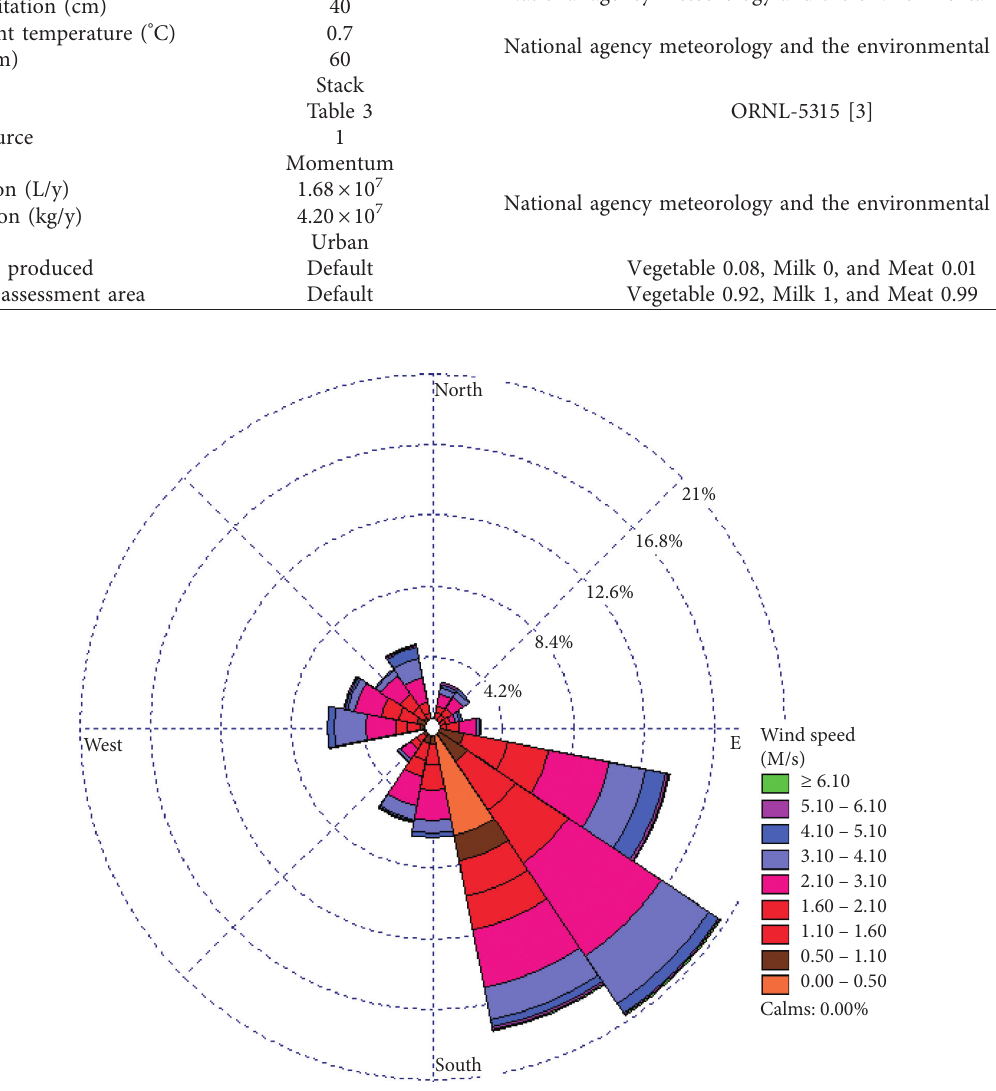
Figure 2: The wind rose graph.